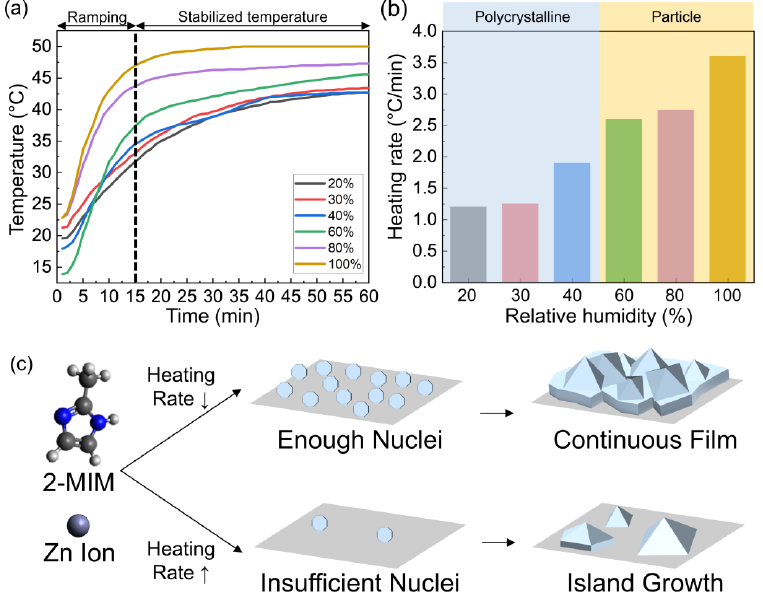
Figure 5. ( a ) Temperature profile and ( b ) Heating rate graphs of the reacting solutions during ZIF-8 growth at 50 °C for different relative humidities. ( c ) Schematic diagram of the growth mechanism of ZIF-8 crystals depending on the heating rate of the reaction solution.